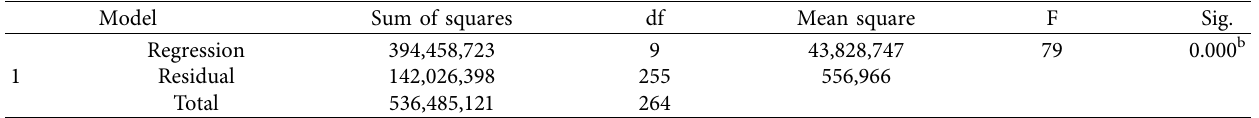
Table 4: ANOVA test for the linear regression model.